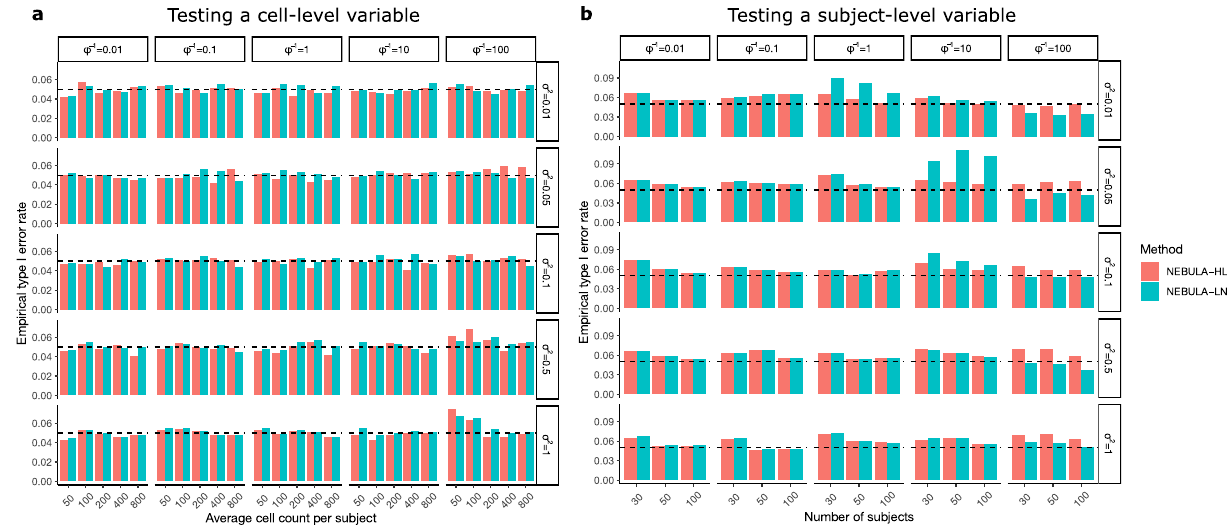
Fig. 3 Empirical type I error rate of testing cell-level and subject-level variables using NEBULA-LN and NEBULA-HL. a The empirical type I error rate of testing a cell-level variable using NEBULA-LN (blue) and NEBULA-HL (red) under different combinations of CPS, σ 2 , and ϕ . The number of subjects was set at 50. b The empirical type I error rate of testing a subject-level variable using NEBULA-LN (blue) and NEBULA-HL (red) under different combinations of the number of subjects, σ 2 , and ϕ . The CPS value was set at 400. The type I error rate was calculated from n = 500 simulated replicates in each of the scenarios and was evaluated at the signi fi cance level of 0.05 (the dashed lines). We used the higher-order Laplace approximation in NEBULA-HL for scenarios of low CPC. CPS: cells per subject. CPC: counts per